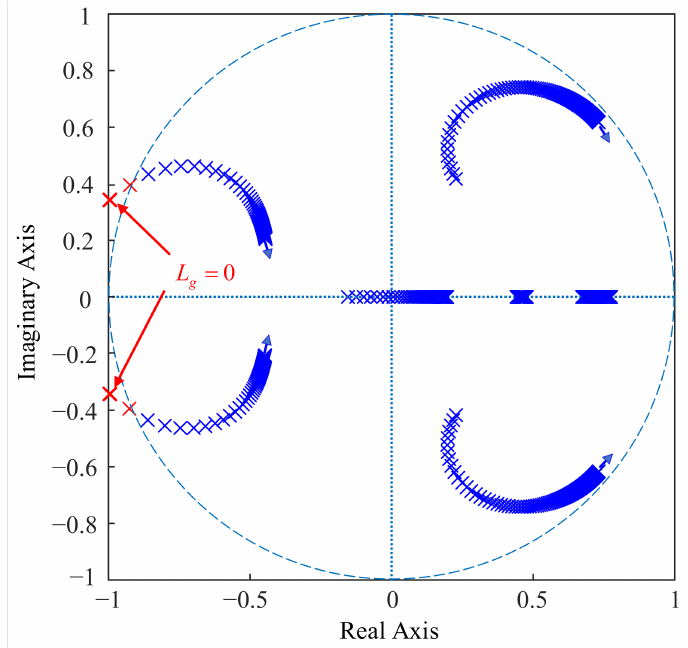
Figure 19. Closed-loop pole map using the calculated capacitor current i c (cid:48) for